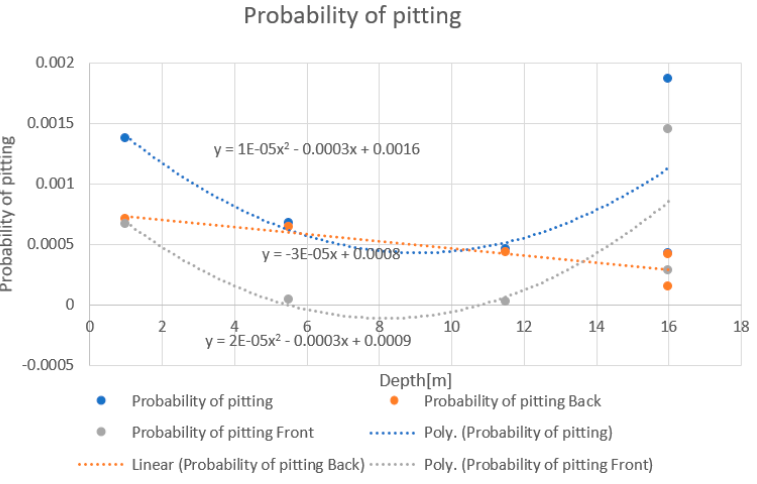
Figure 9. Probability of pitting.